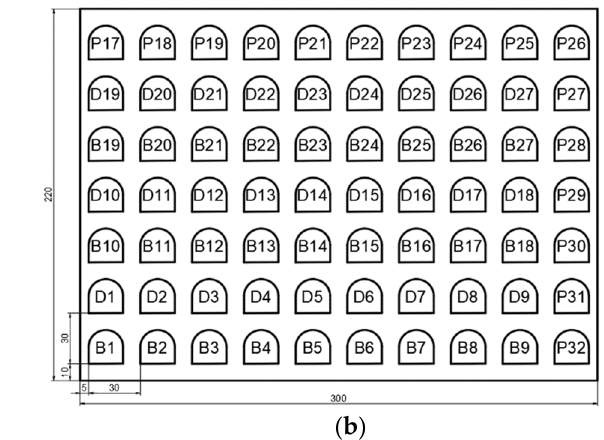
Table 2. Working parameters. Parameter (Unit of Measure)